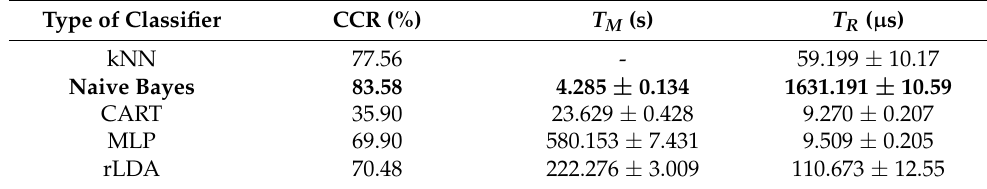
Table 7. Classification results for individual classifiers with Group 6 attributes.